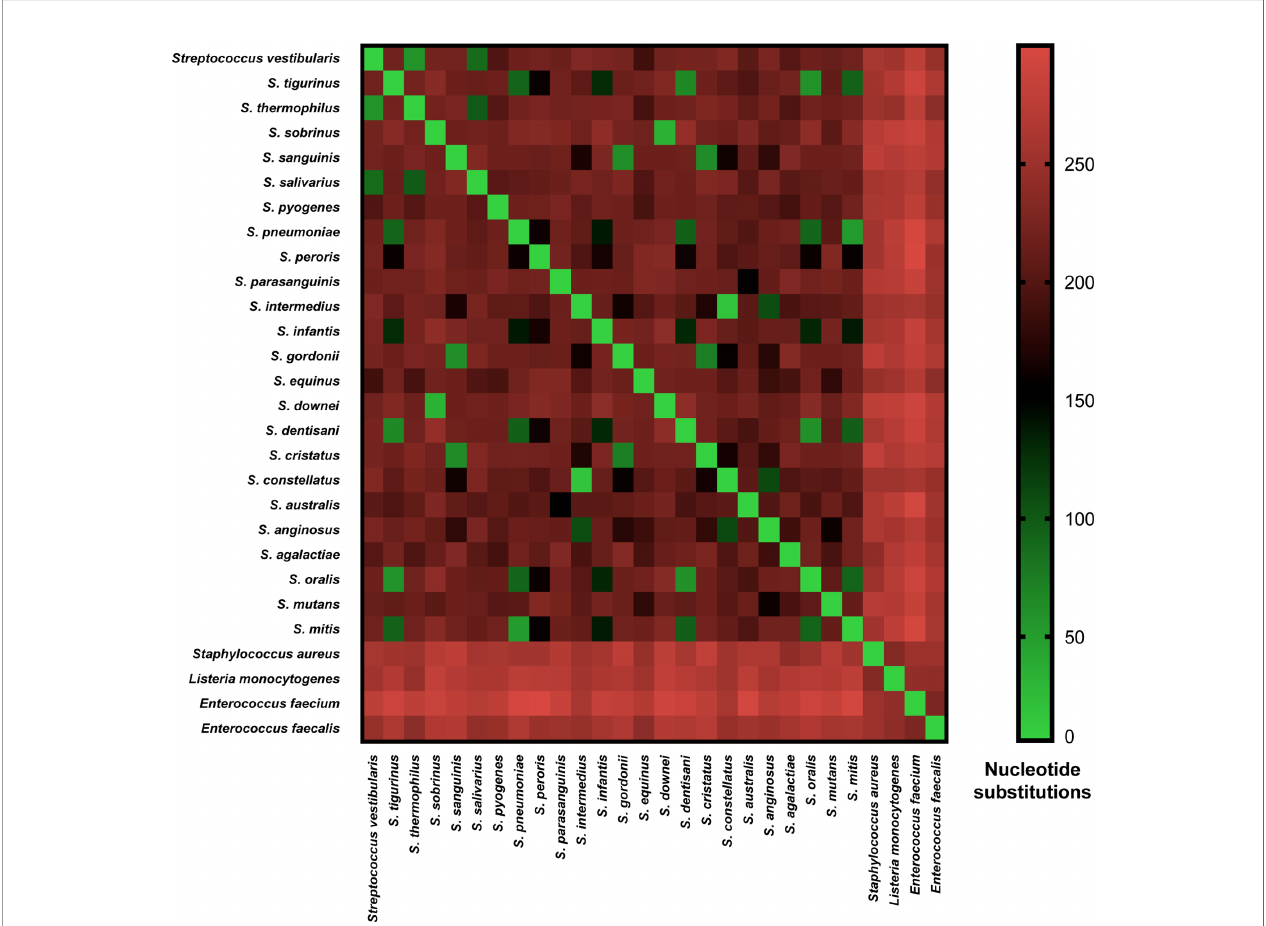
FIGURE 3 | Pairwise nucleotide substitutions heat map. Number of nucleotide substitutions over a 525-630 bp coaE gene sequence between 28 different bacterial species as a measure of evolutionary